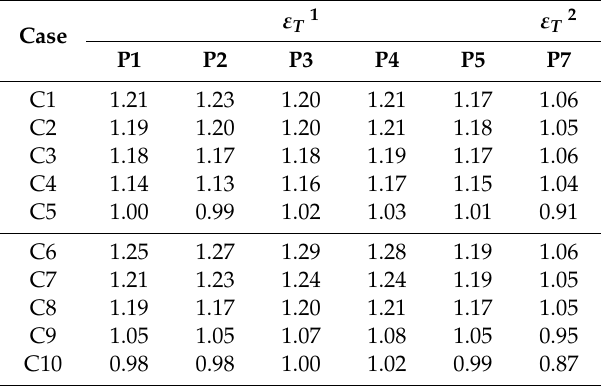
Table 3. Average ε T in locations P1–P7 for all